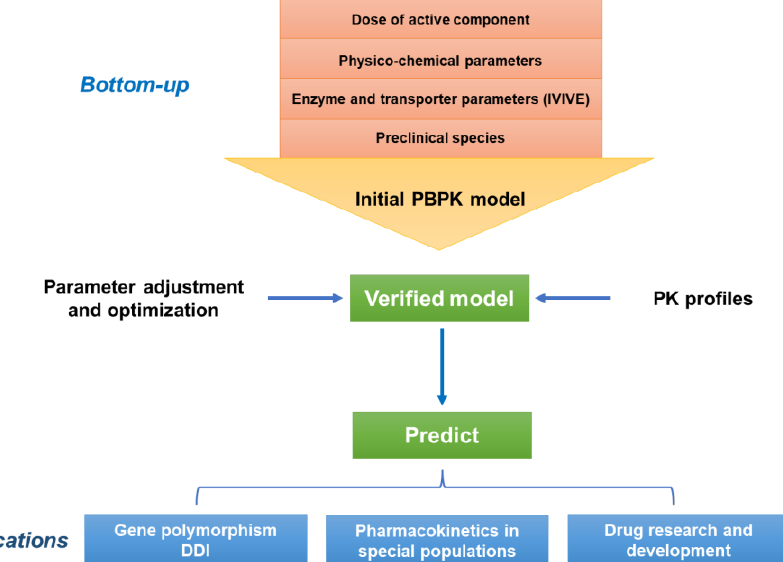
Figure 1. Strategies for studying the pharmacokinetics of natural medicine using the PBPK model. IVIVE: in vitro – in vivo extrapolation; PBPK: physiologically based pharmacokinetic; PK: pharma- cokinetic; DDI: drug – drug interaction .